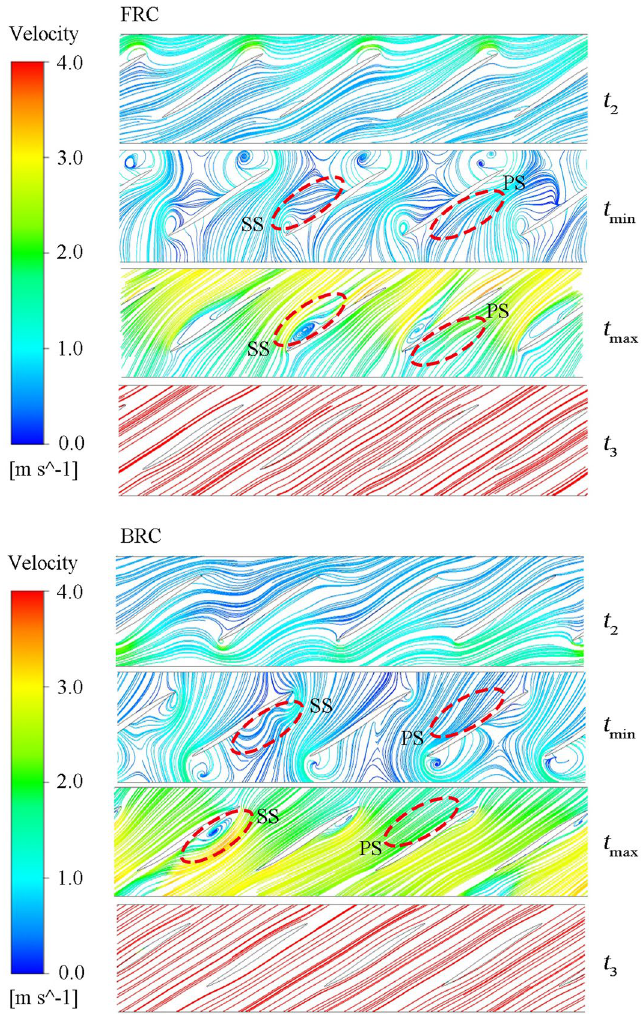
Figure 14. The streamlines on the blade to blade surface at span = 0.5 under FRC and